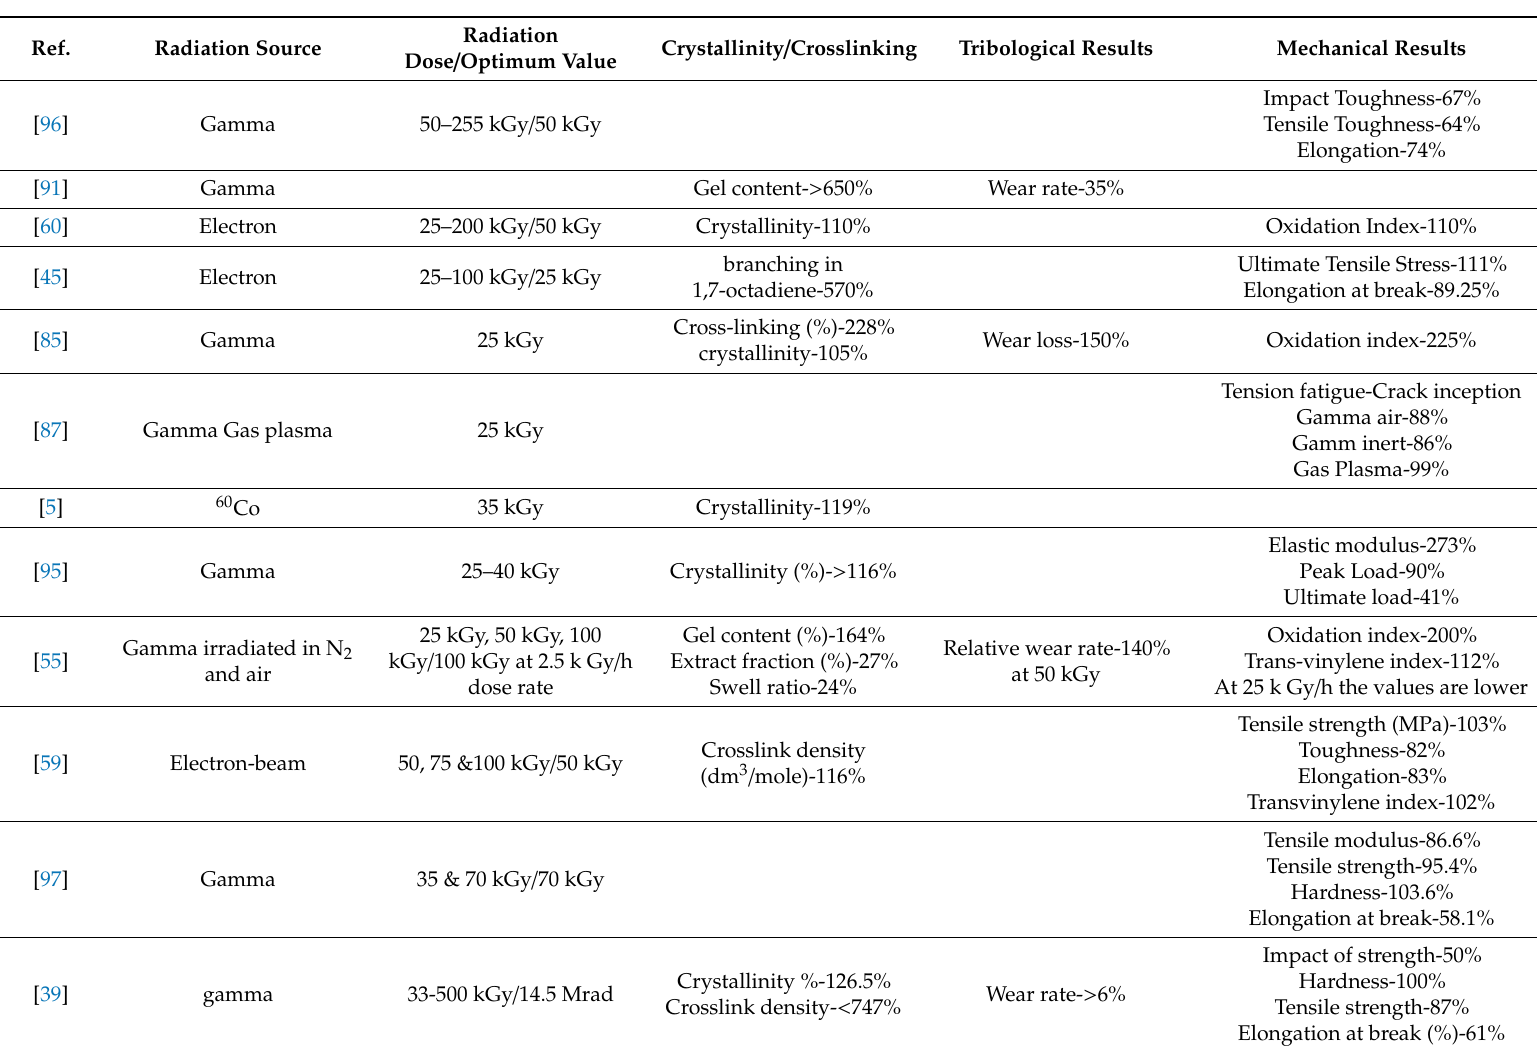
Table 2. Influence of irradiation on crosslinking, tribological and mechanical performance for UHMWPE.